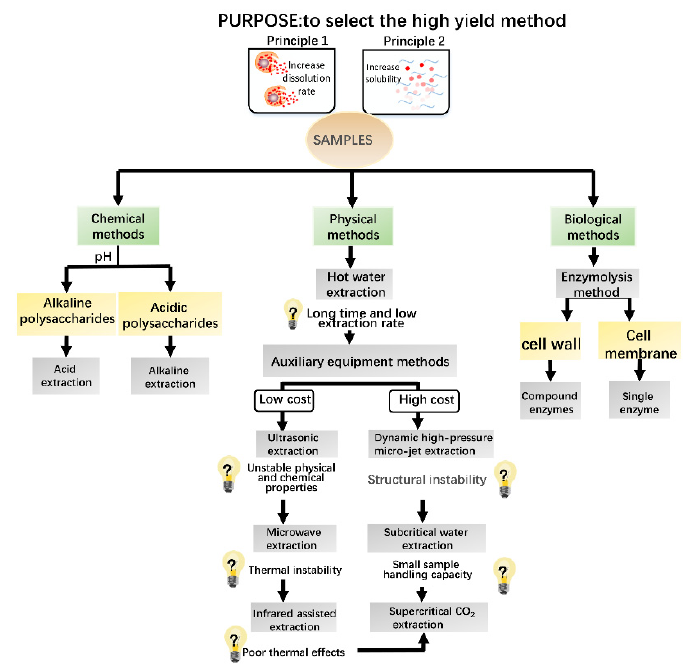
Figure 3. Strategic map for selection of natural polysaccharide extraction methods.